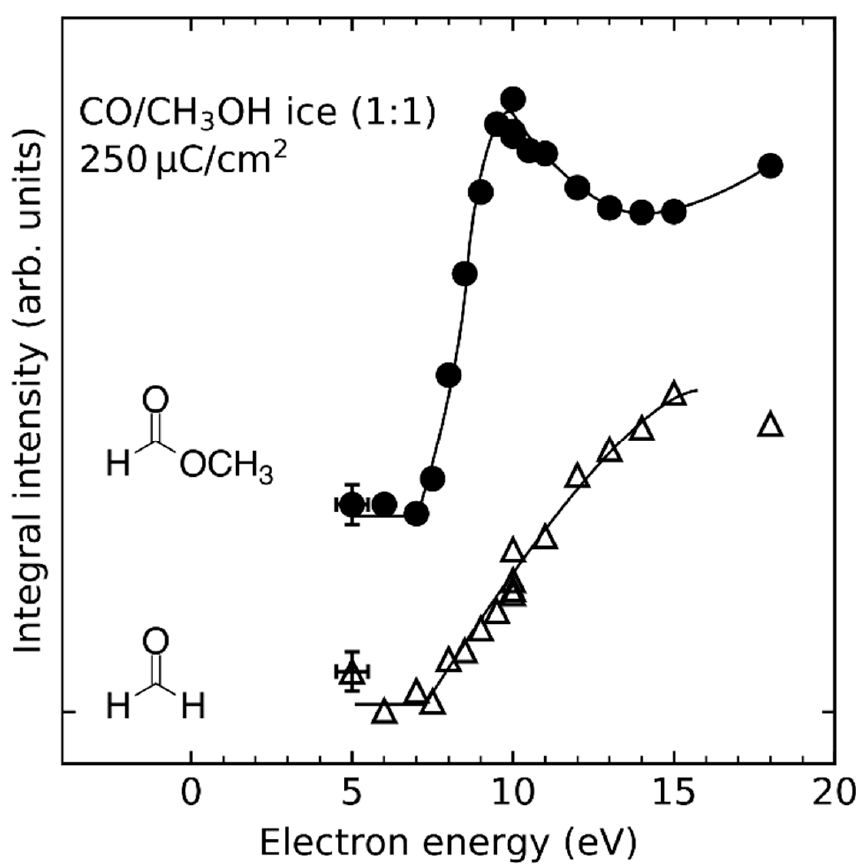
Figure 14. Comparison of the dependencies of the integrated desorption signals of methyl formate ( • ) and H 2 CO ( (cid:97) ) on electron energy obtained by TDS after irradiation of CO/CH 3 OH (1:1) mixed ices with 250 µ C/cm 2 . The solid lines serve as a guide to the eye. Adapted from Ref. [26] with permission from the PCCP Owner Societies.